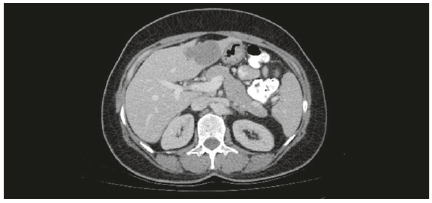
Figure 2: Liver hydatid cyst in abdomen